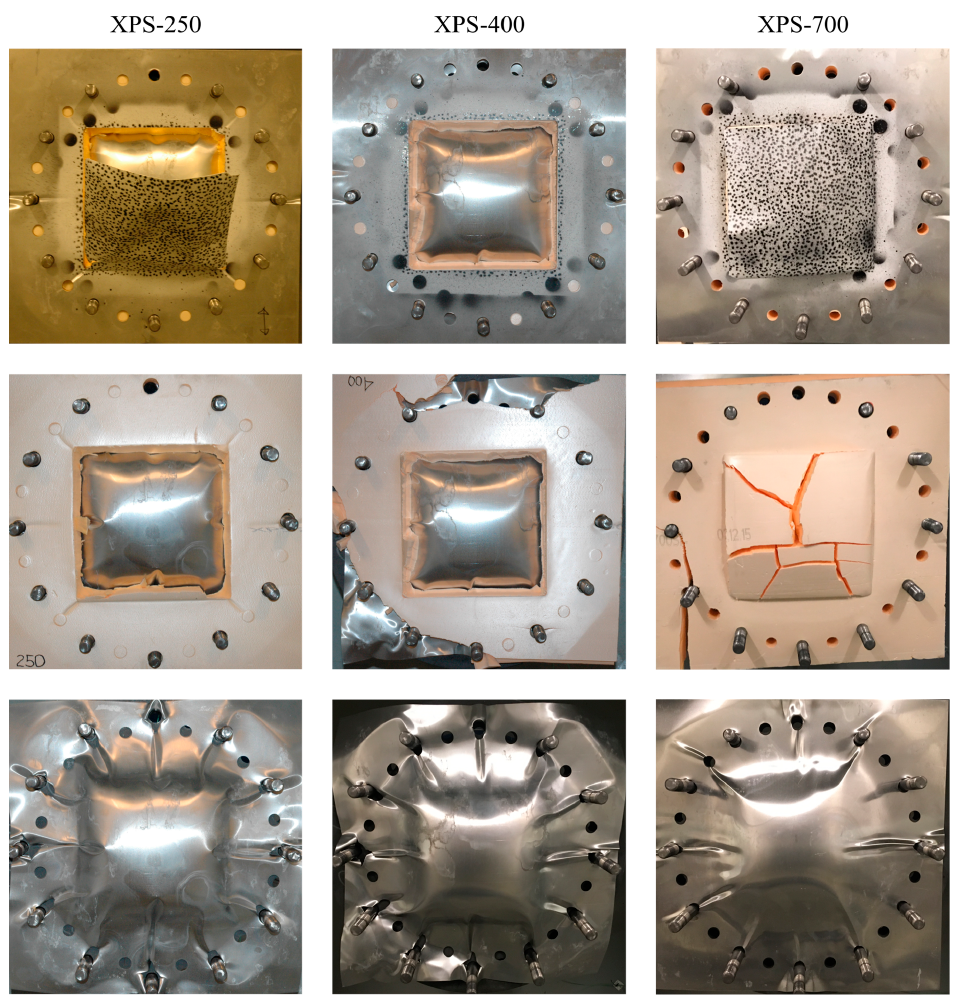
Figure A4. Post-test images of back skins (top), core (middle) and front skins (bottom) for series 2 at load level P15.